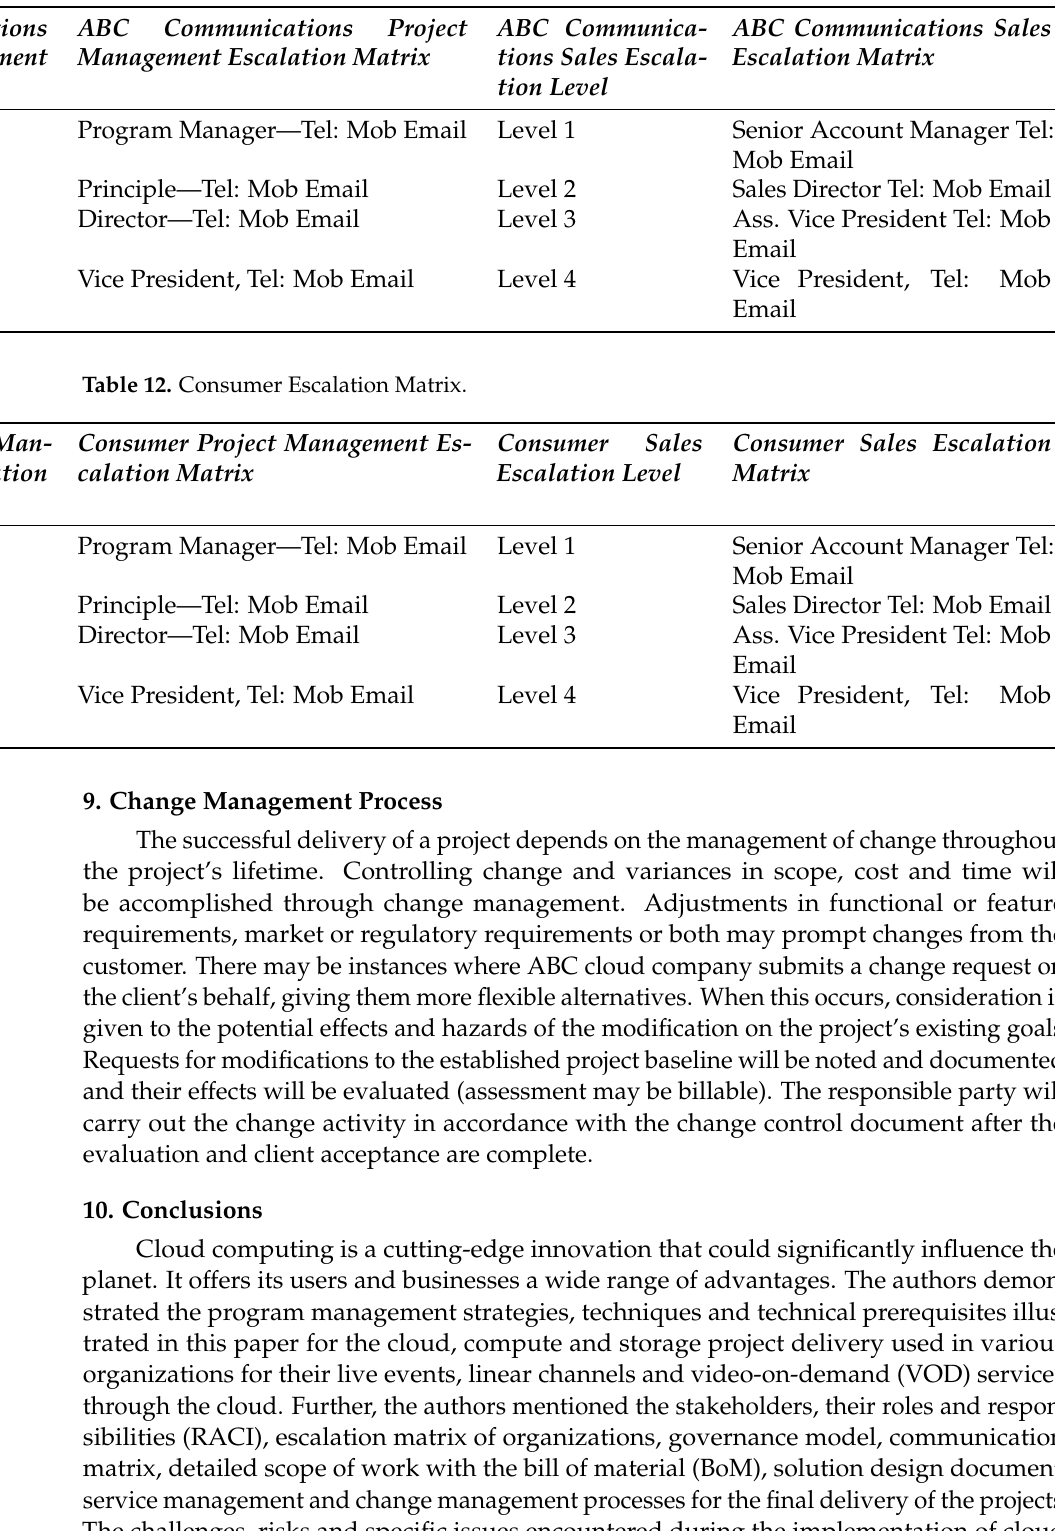
Table 11. ABC cloud company Escalation Matrix.